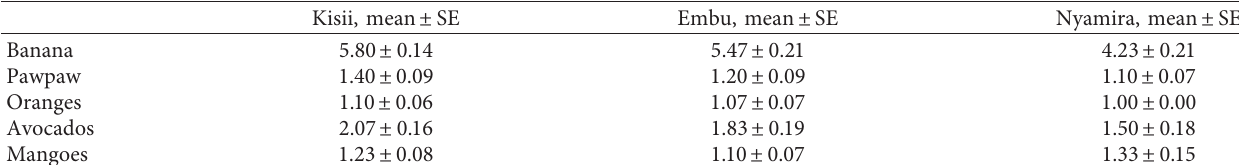
Figure 4: Crops grown by farmers in Embu, Kisii, and Nyamira counties. Table 2: Yield index of fruits in Kisii, Nyamira, and Embu